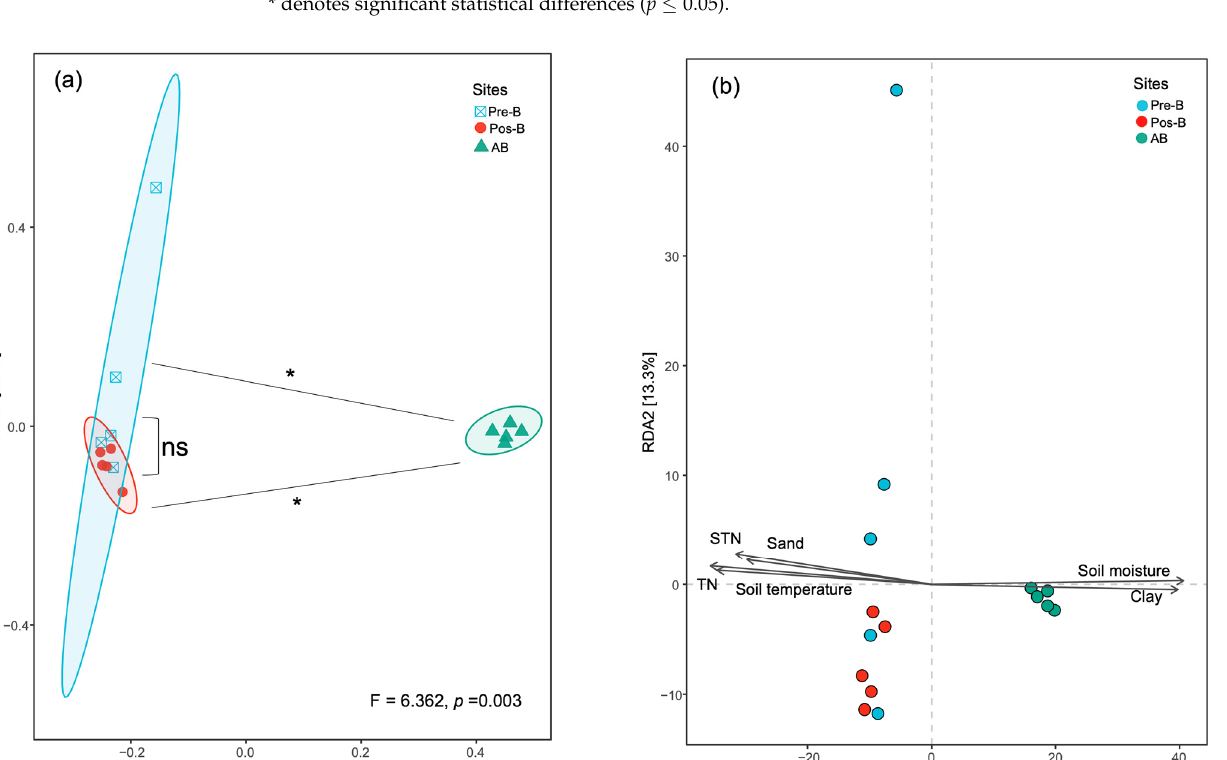
Table 4 . Correlations and significant values of the bacterial communities and soil properties determined with the Mantel test . Soil Properties